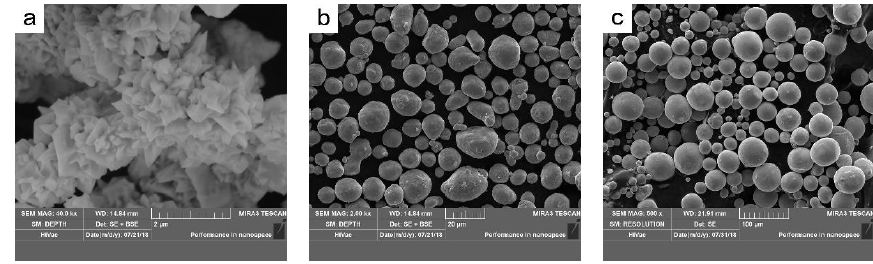
Figure 1. The powders used to prepare the reactive liners. ( a ) Ni; ( b ) Al; and ( c ) Cu. Table 1. The characteristics of powder mixtures.